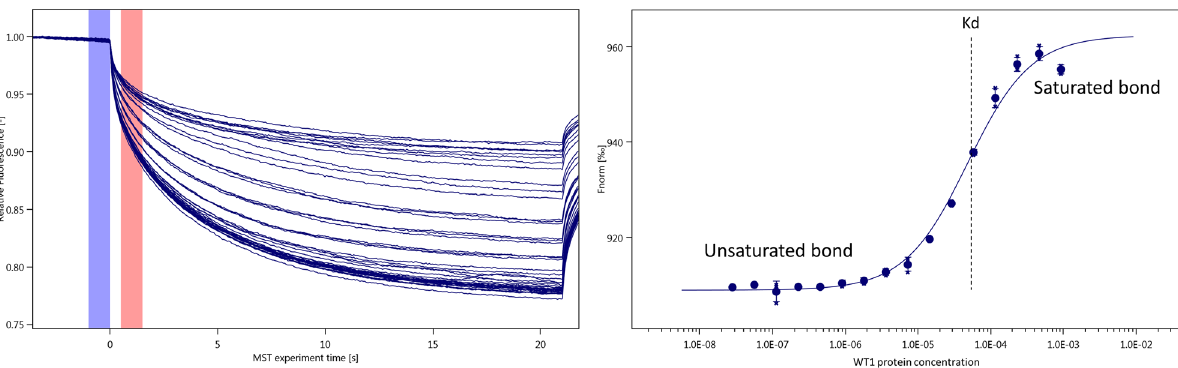
Figure 3. Satisfactory MST traces achieved with optimized MST assay buffer. Left: The curves represent the decrease in fluorescence over time after the application of heat induced by laser. The purple strip marks the baseline while the red strip indicates the point of interest. Right: Normalized fluorescence change in samples of DNA and serially diluted protein. If binding is present, an ”S-affinity curve” is seen and the dissociation constant (dashed line) may be